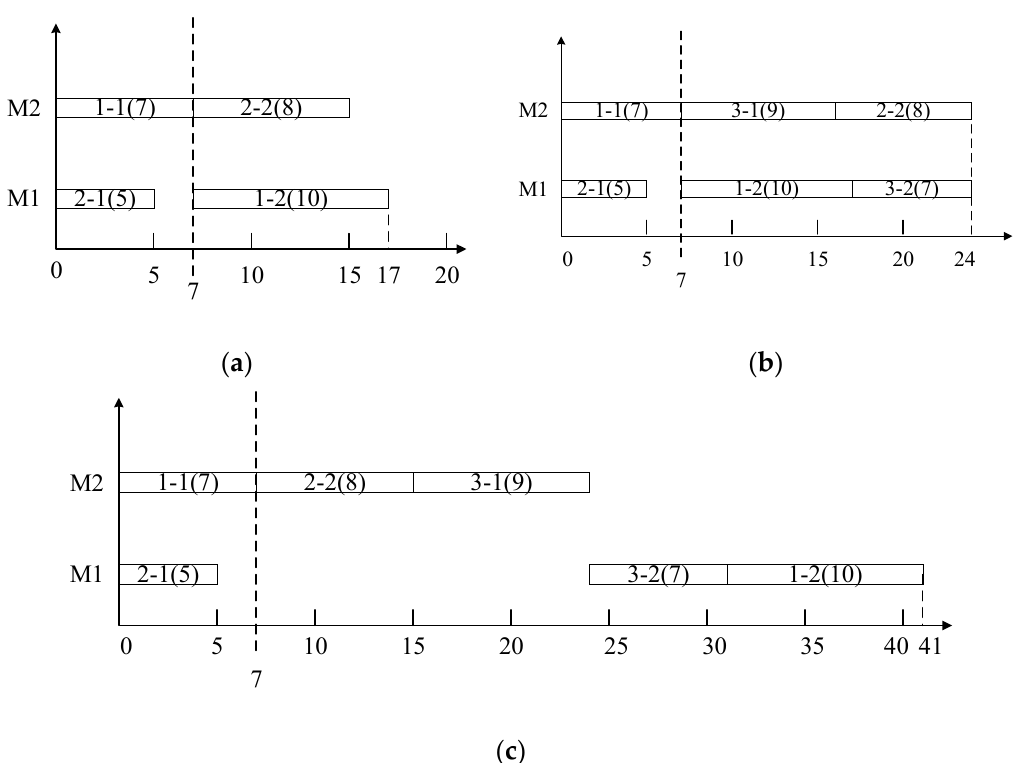
Figure 1. A simple example. ( a ) The Gantt Chart via SPT at time 0. ( b ) The Gantt Chart via LPT at time 7. ( c ) The Gantt Chart via SPT at time 7.